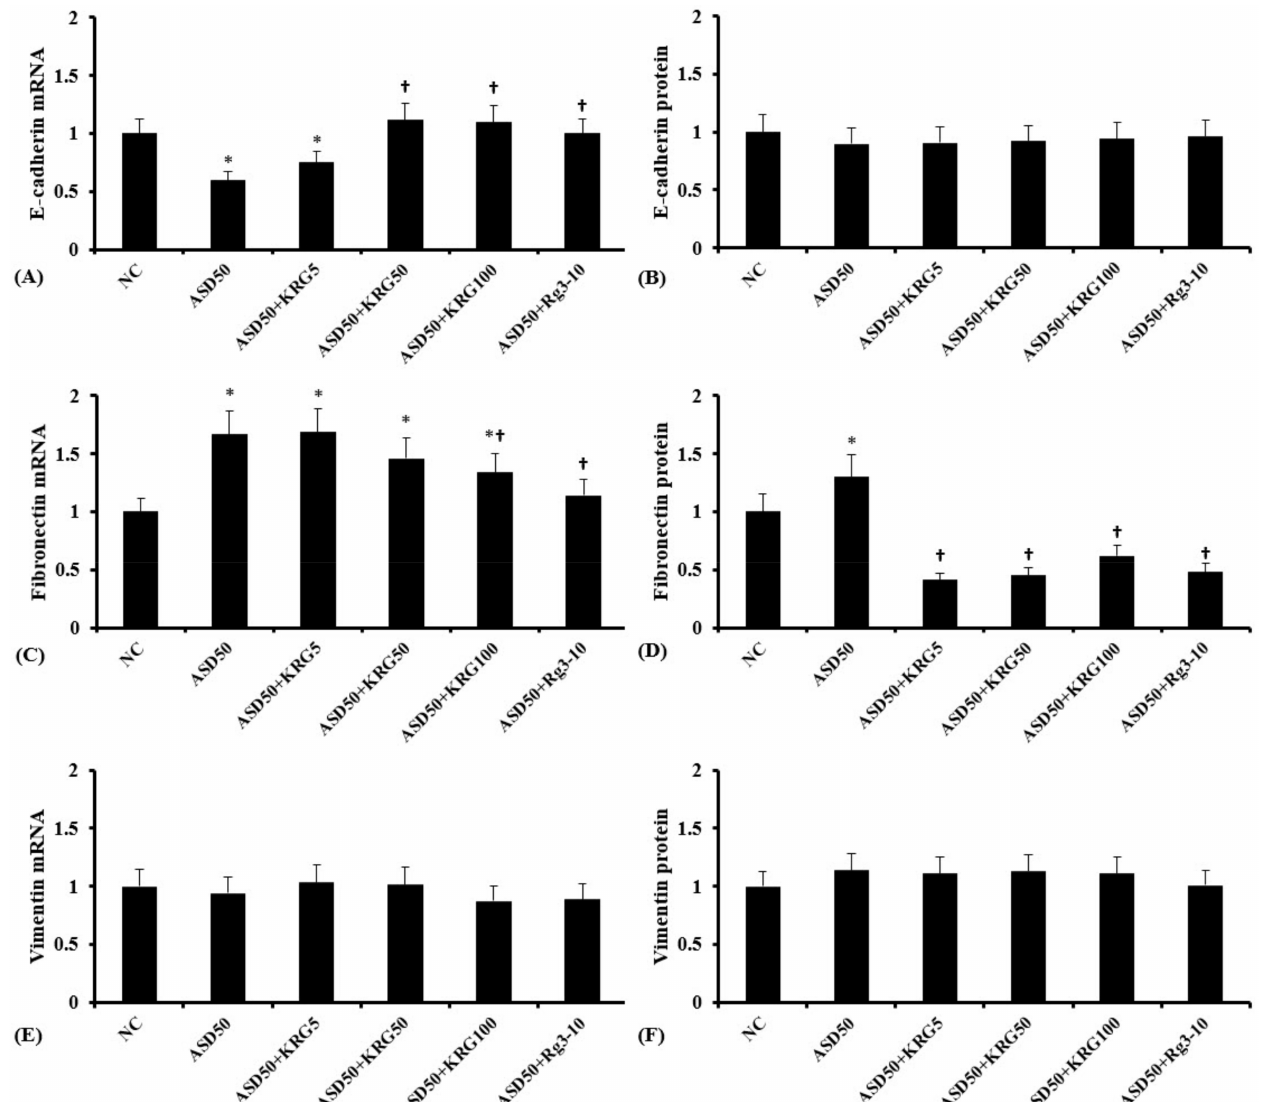
Figure 2. Effects of Korean red ginseng (KRG) and ginsenoside Rg3 on Asian sand dust (ASD)- induced EMT marker mRNA and protein alterations in nasal epithelial cells. Cells were pretreated with or without KRG (5, 50, or 100 µ g/mL) or Rg3 (10 µ g/mL), and were then stimulated with ASD (50 µ g/mL). KRG and Rg3 suppressed the ASD-induced downregulation of E-cadherin mRNA ( A ) expression and the upregulation of fibronectin mRNA ( C ) and protein ( D ) expression in nasal epithelial cells. However, ASD, KRG, and Rg3 did not influence the expression of E-cadherin protein ( B ), vimentin mRNA ( E ), and protein ( F ) expression. NC: negative control (NC means nasal epithelial cells were not treated with ASD, KRG, or Rg3). *: p < 0.05 compared with NC. †: p < 0.05 compared with the ASD-stimulated group, n =